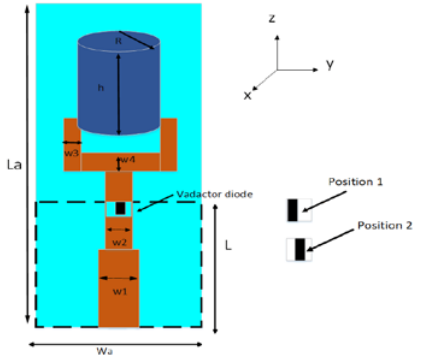
Figure 1: cylindrical DRA shaped UWB planar monopole antenna loaded by a single varactor diode. Table 1: The design parameters of the proposed antenna